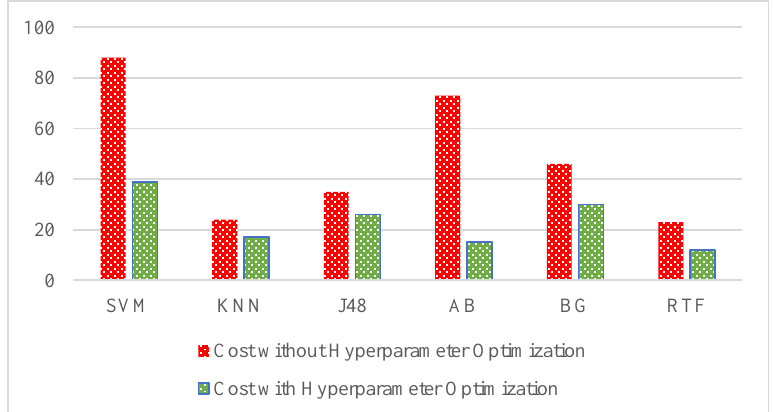
Figure 11. Cost comparison of machine learning models without and with optimization.